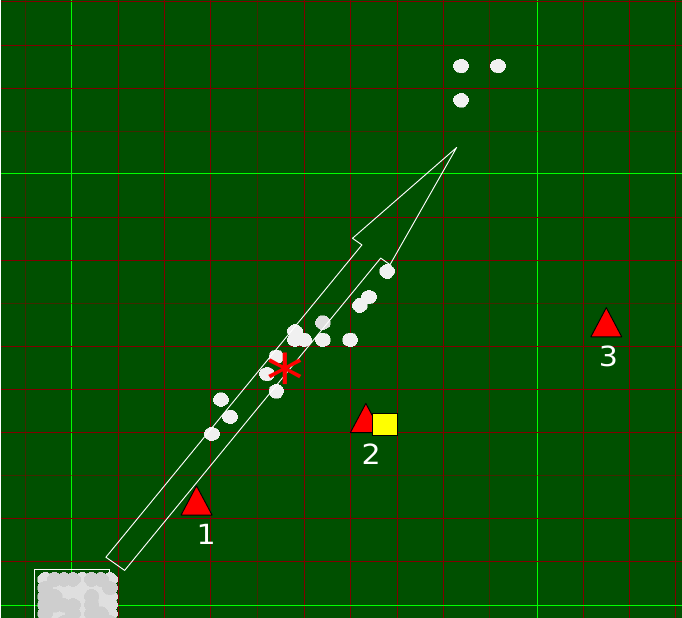
Figure 12. Ground-level PM average concentrations above background simulated for a 2.5 2-hour period beginning at ignition for the MM5 meteorological sounding. The small squares represent 1 mi (1.6 km) and the light green square represents 10 mi (16 km). The axis of the plume is given by the white arrow. Also shown are locations of the ceilometer sampling units (red triangles). (yellow square) and three PM 2.5